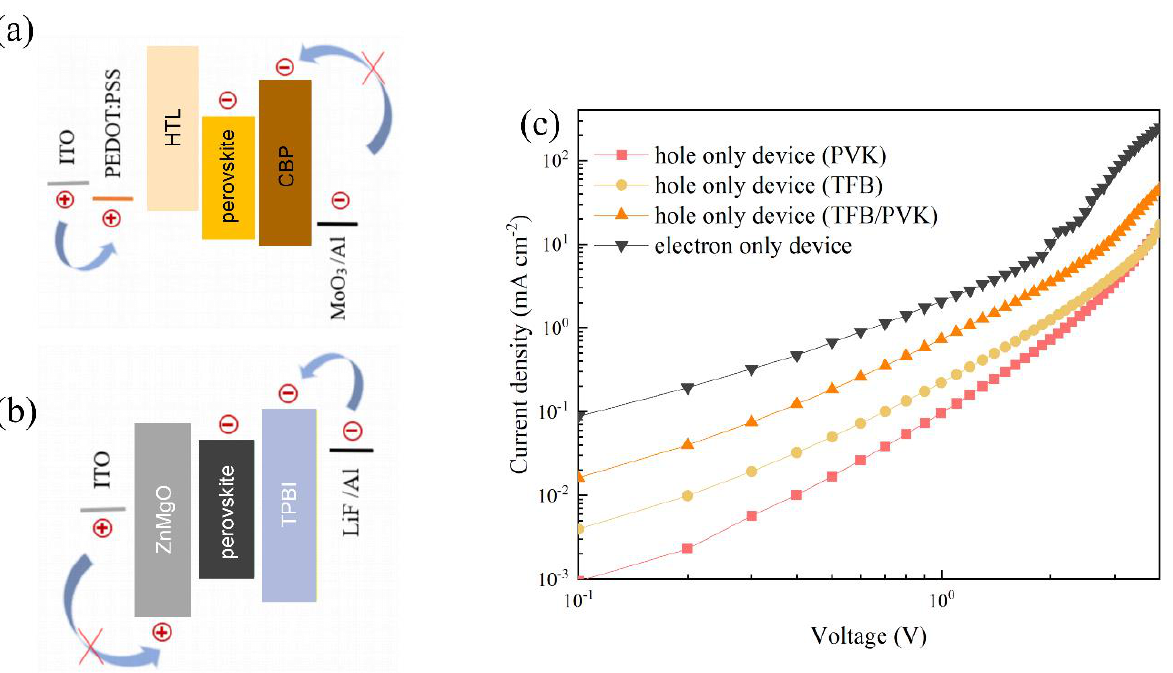
Figure 6. ( a ) Energy level structure diagram of a hole − only device with different hole − transport layers ( b ) Energy level structure diagram of an electron − only device with TPBi as the electron transport layer ( c ) J − V curves of the hole − only and electron − only devices with TFB, PVK, and TFB/PVK